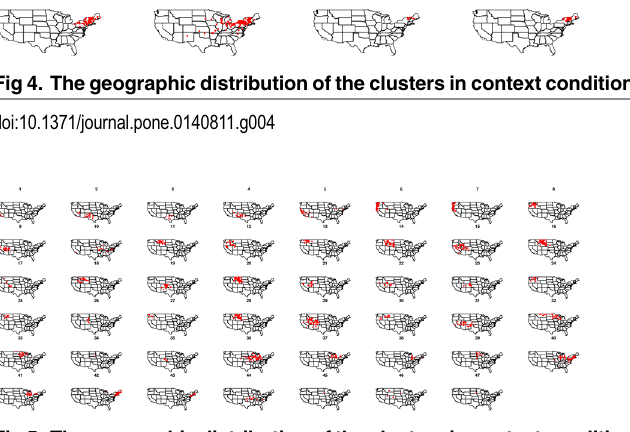
Fig 5. The geographic distribution of the clusters in context condition of common